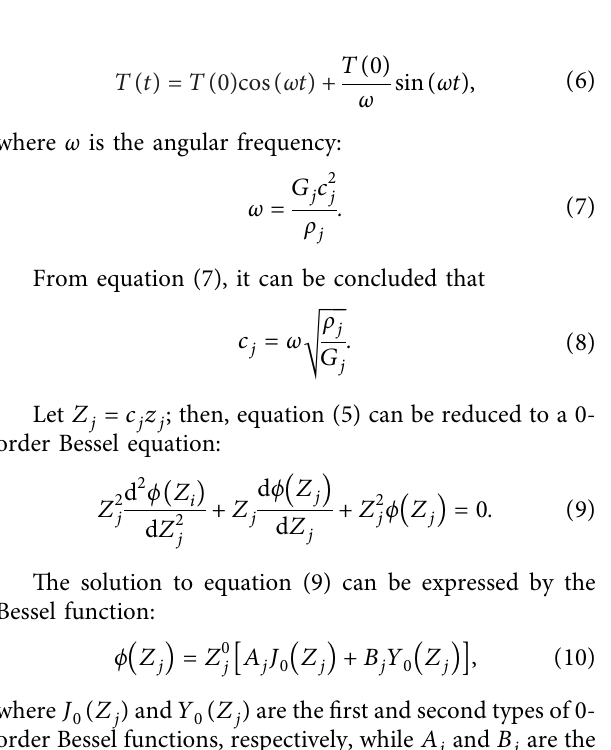
Figure 7: Force analysis of the